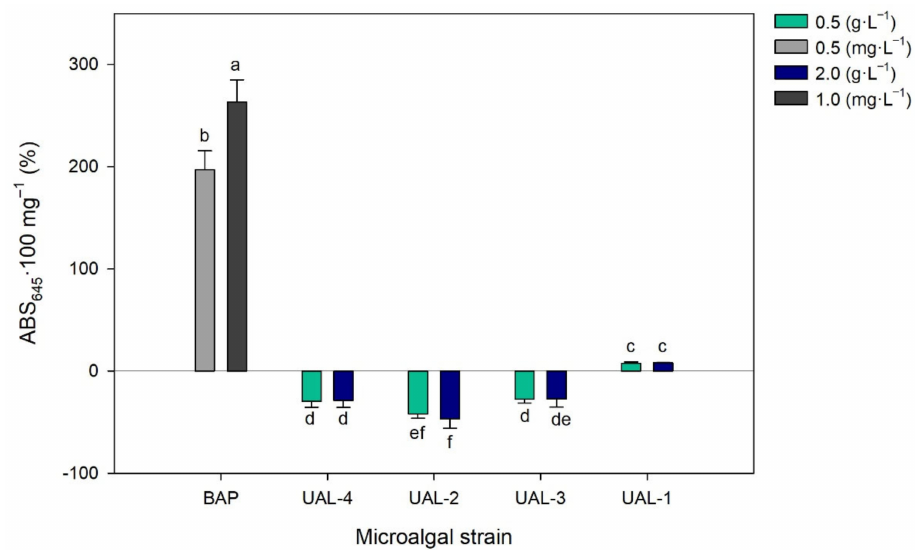
Figure 6. Effect of the microalgal extracts on the chlorophyll content of the detached wheat leaves. Values represent the percentage of variation in the ABS 645 /100 mg ratio with respect to the control (distilled water). Values represent the mean values ± SD. Different letters indicate significant differences ( p <